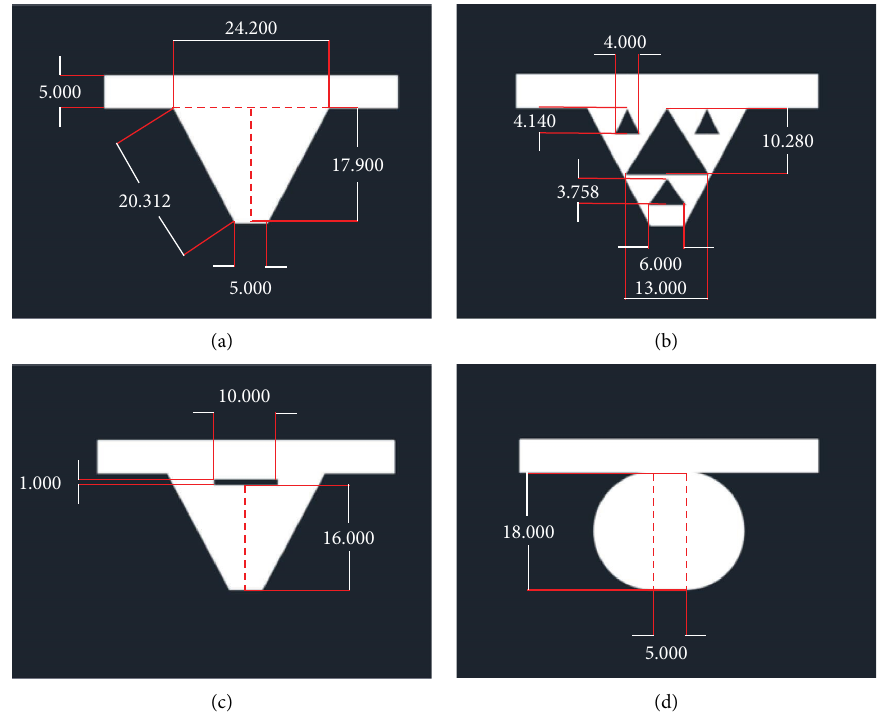
Figure 7: AutoCAD geometries and dimensions in μ m of (a) bowtie, (b) fractal, (c) slotted, and (d) circular, metallic